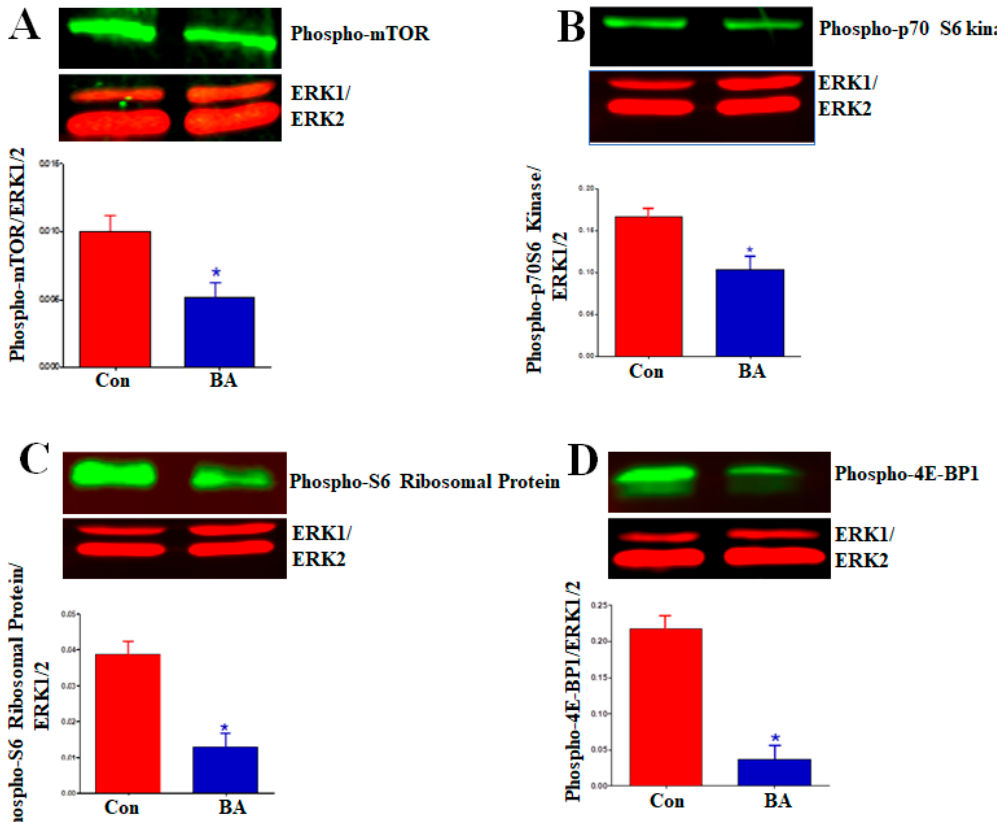
Figure 8. Inhibition of activation of mTOR and its downstream targets by butyrate in VSMCs. Cell lysates prepared from VSMCs treated with (BA) or without (Con) butyrate were analyzed by Western blotting using antibodies specific to ( A ) phosphorylated mTOR, ( B ) Phosphorylated p70S6 kinase, ( C ) phosphorylated S6 ribosomal protein and ( D ) phosphorylated 4E-BP1. Appropriate second antibodies labelled with IRDye 680LT or IRDye 800CW were used for detecting target proteins. LI-COR CLx imaging system and Image Studio software were used for scanning and quantitating signal intensities. (* p < 0.01 vs Control).